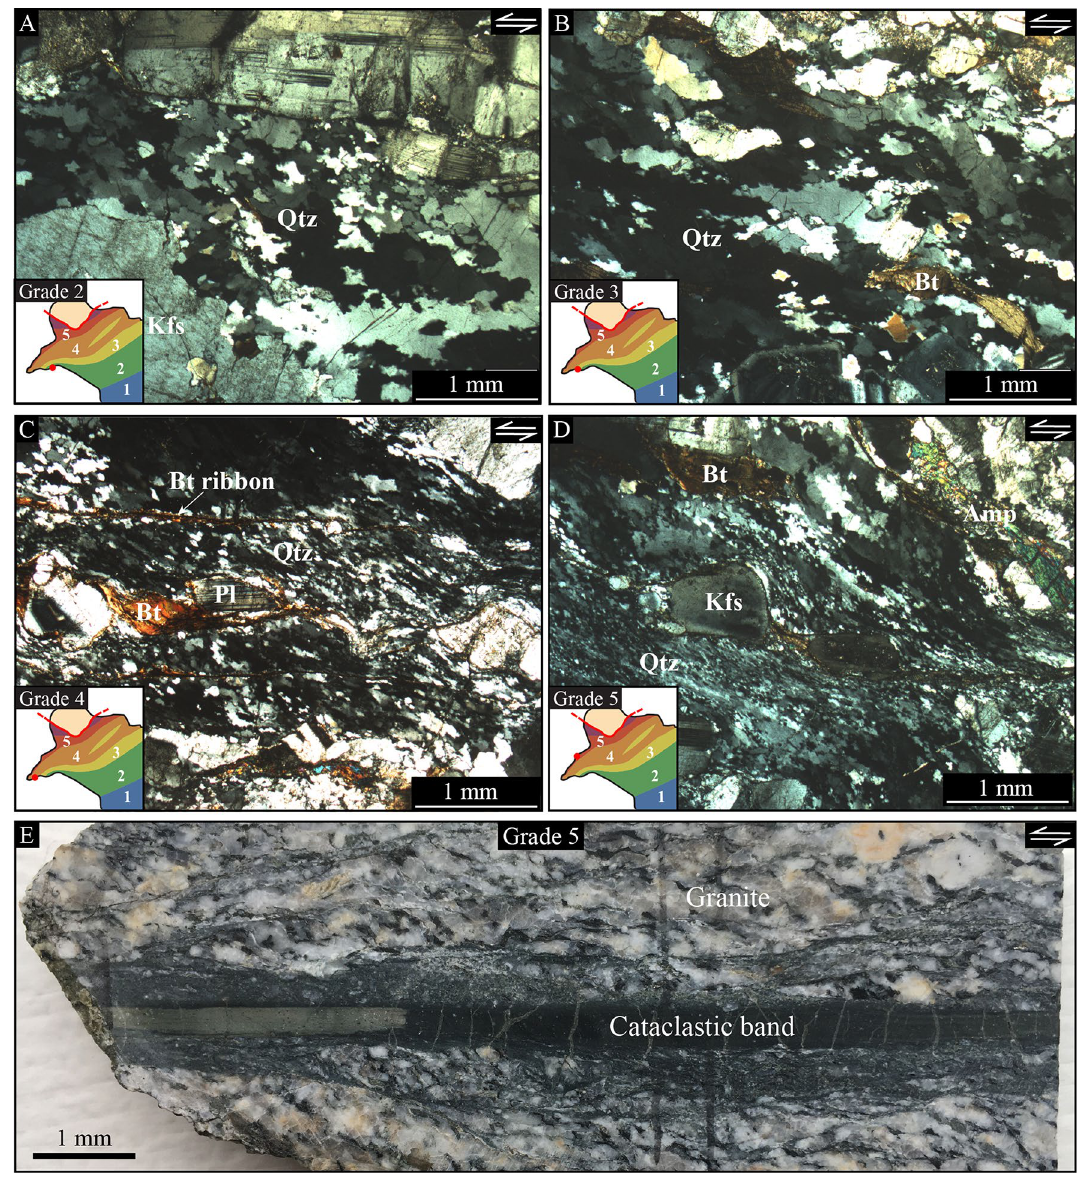
Figure 2. Microstructural view of quartz-rich shear bands and related features. ( A–D ) Cross-polarized optical microscopy images of shear bands from grade 2 to grade 5. The subset gives the sample location. Qtz quartz; KFs K-feldspar; Pl Plagioclase; Bt Biotite. ( E ) Hand-scale sample of a cataclastic layer from grade 5. All samples are shown in the X–Z structural plane with top-to-the-left tions). This map describes strong intragranular misorientations of quartz grains, which may locally exceed 30°, particularly where strain has been localized (Fig. 5A). This always coincides with grain size reduction and an increase in low-angle boundary density, together with an overall clustering of the quartz [c]-axes around the car- dinal axis ([Y]) with increasing strain (Fig. 5B). The occurrence of myrmekite that develops around K-feldspar is also observed, but not systematically related to the development of shear bands. Accordingly, quartz lattice- (or crystallographic-) preferred orientation (LPO) concentrates the [0001] c axes around [Y] and < 11 2 0 > a axes around 3 points maxima distributed normal to [Y] at 60° from each other. While these < a > maxima more or less smear out depending on the grade and shear band area 27 , the strongest one always tends to align with the lineation [X] (Fig. 5C and supp. Fig. 2). The distribution of [c] axes also describe half of a girdle that extends towards the [Z] axis and may locally give rise to two maxima on each side of the [Y] axis (supp. Fig. 2). This fabric is typical of a Y-maxima LPO 29 and characterizes most of quartz-rich shear bands all over the pluton 27 . Its strength ranges from moderate to strong within the shear bands with J indices higher than 2 and M indices higher than 0.2 (J and M are defined in the ‘Method’ section). In relation to this, low-angle boundaries are related to lattice ‘cross-boundary’ rotation axes that mostly cluster around the [c] axis, indicating dominant slip of dislocations on {m} plane in the < a > direction (Fig. 5D), also referred to as prism- < a > slip system 30,31 .